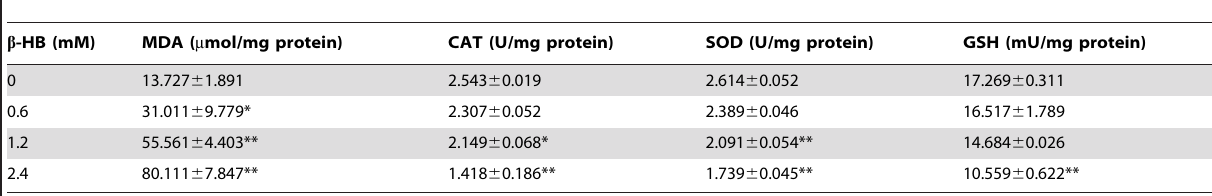
Table 1. Effects of b -HB on lipid peroxidation, glutathione level and antioxidant enzyme activities in BSMCs.